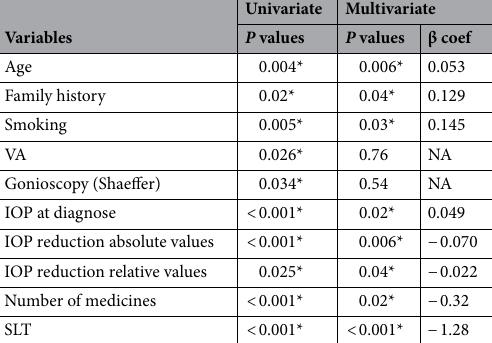
Table 2. Significant variables tested in the univariate and the multivariate linear regression analysis using the VFI (ROP) as endpoint. (*) Significant values. VFI Visual field index; ROP Rate of progression; VA Visual acuity; IOP Intraocular pressure; SLT Selective Laser Treatment; NA Non-applicable.